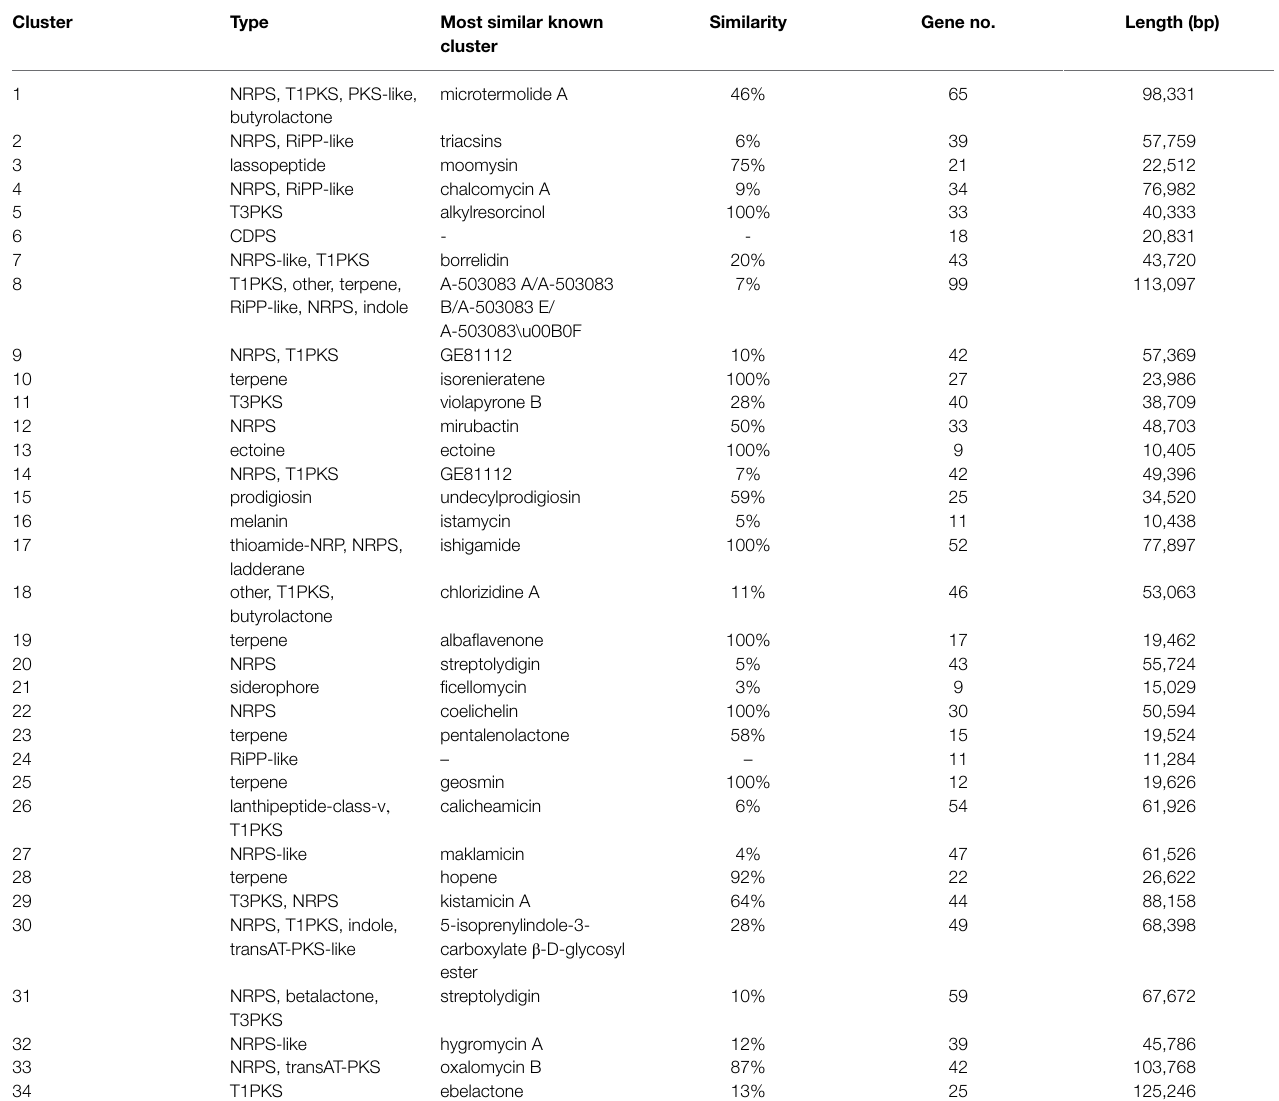
TABLE 2 | Secondary metabolite clusters in S. alfalfae XN-04. Cluster Type Most similar known